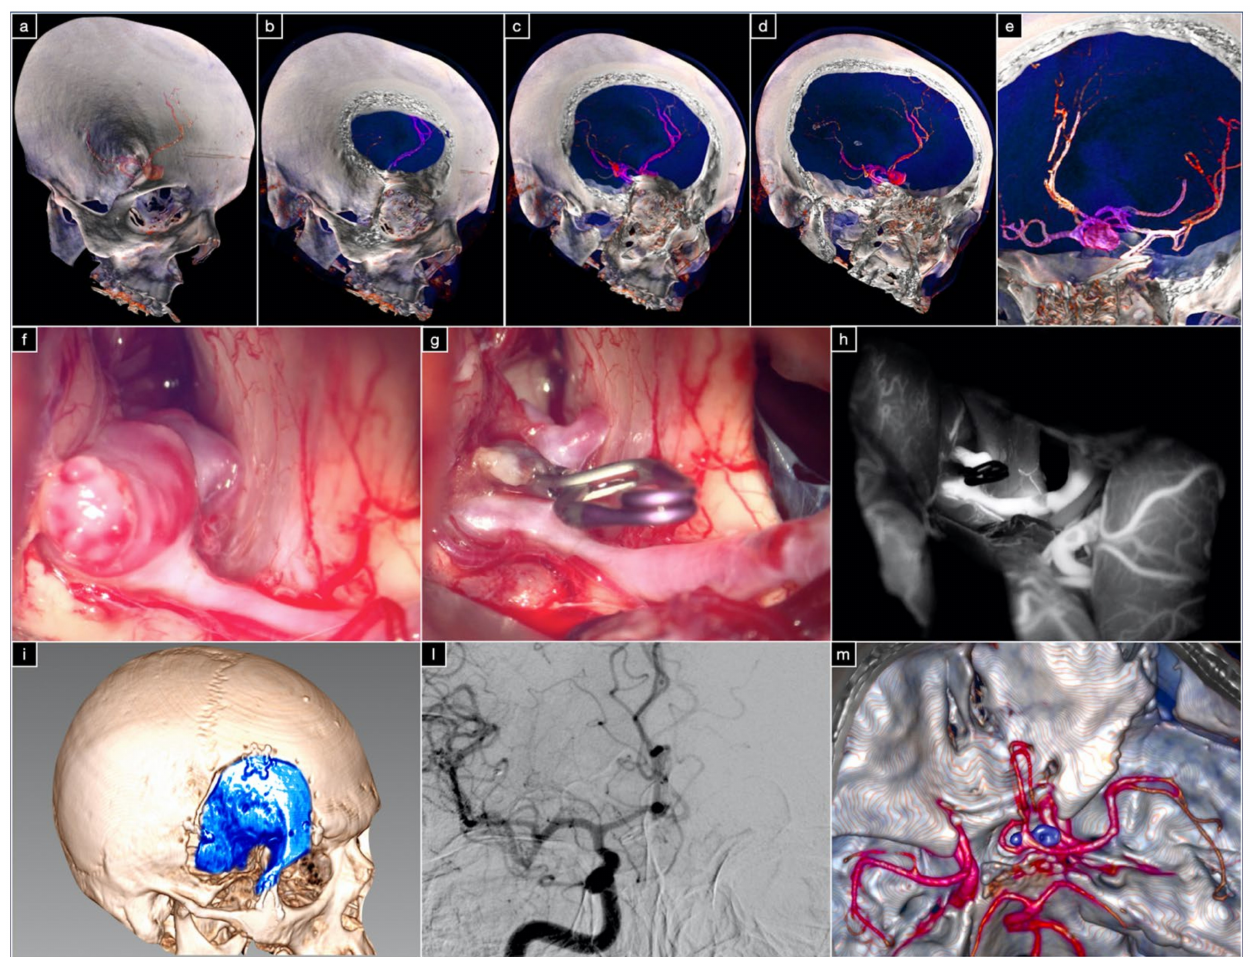
Figure 8. ( a – e ) Three-dimensional (3D) volume-rendered preoperative CT angiography. Intraopera- tive pictures taken before ( f ) and after ( g ) clipping of the aneurysm. ( h ) Postclipping indocyanine green videoangiography. ( i ) Three-dimensional (3D) volume-rendered postoperative CT scan show- ing the orbitopterional approach. ( l ) Digital subtraction angiography of the right internal carotid artery in anterior–posterior projection. ( m ) Postoperative 3D volume-rendered CT